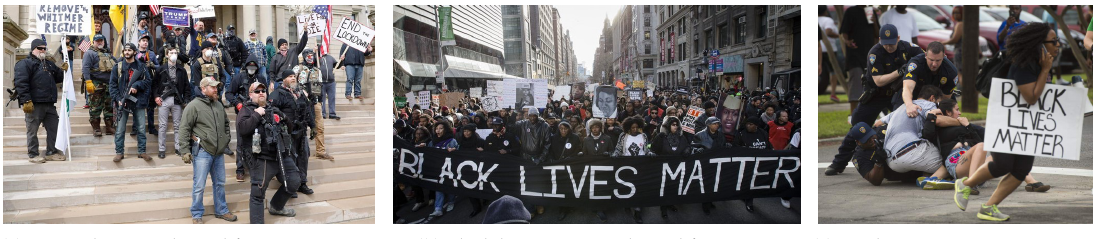
Figure 3. Complex emergencies and protesting during